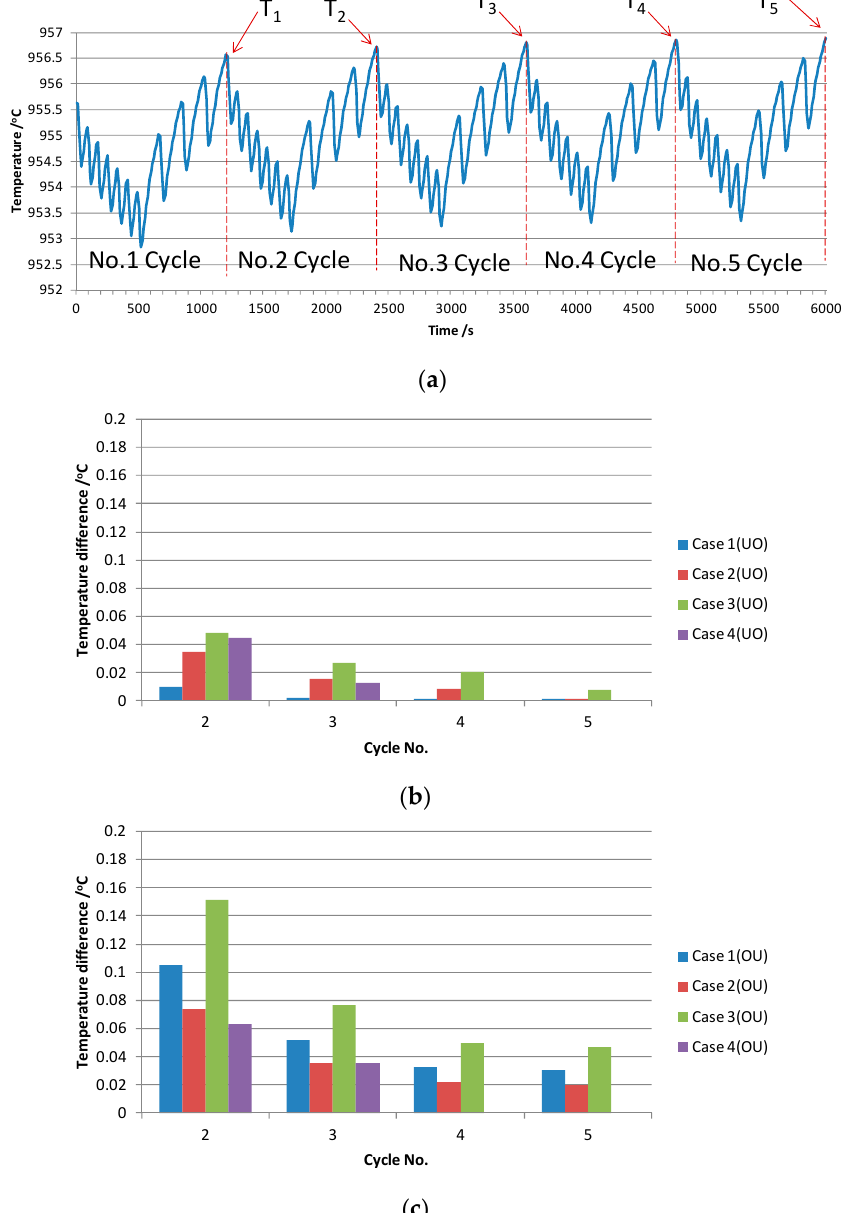
Figure 7. Temperature curves of Cases 1-4 under overfeeding followed by underfeeding. ( a ) Case 1 (OU), overfed (t = 100 s)–underfed (t=150 s); ( b ) Case 2 (OU), overfed (t = 110 s)–underfed (t=130 s); ( c ) Case 3 (OU), overfed (t = 80 s)–underfed (t = 180 s); ( d ) Case 4 (OU), overfed (t = 100 s)–underfed (t = 150 s).